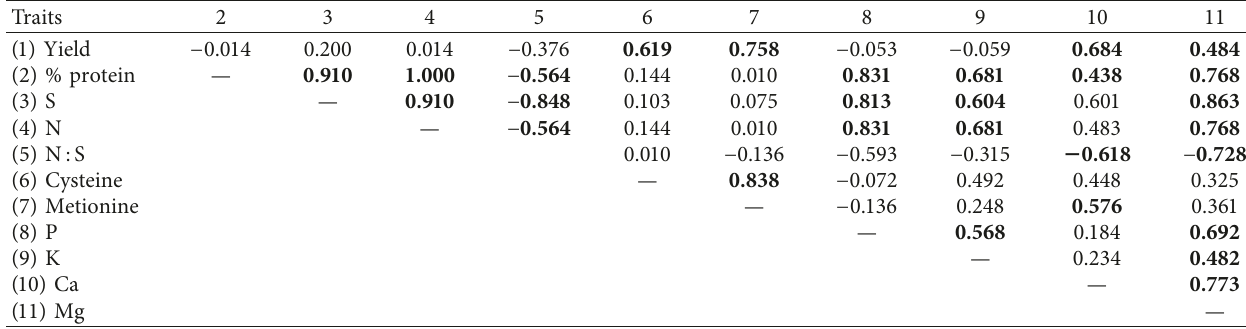
Table 7: Correlation coefficients between yield and some traits of